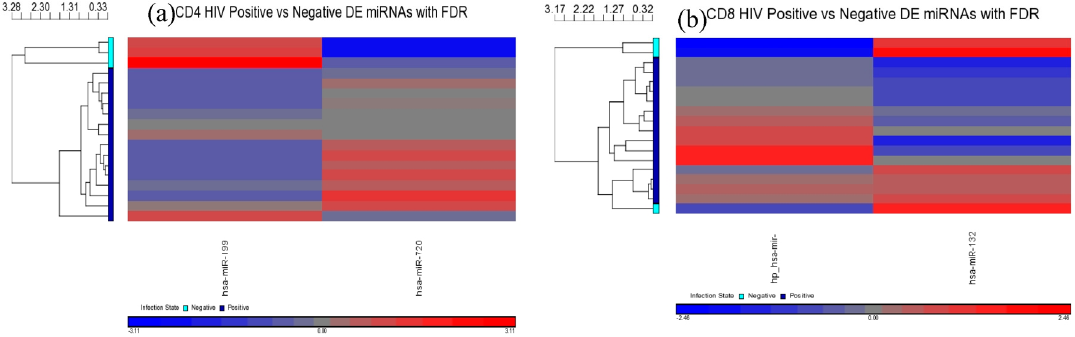
Figure 4. ( a , b ) Heat maps indicating differentially expressed (DE) microRNAs (miRNAs) in HIV+ CD4+ ( a ) and CD8+ ( b ) T-cells compared to negative controls. In each case, uninfected n = 3 and infected n = 15.